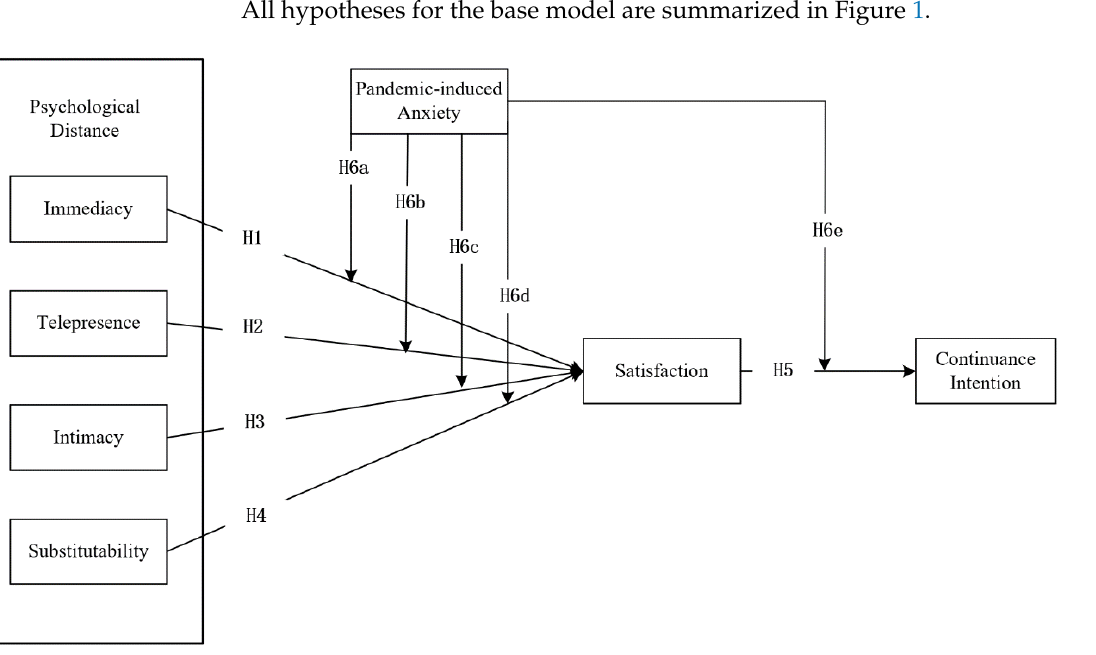
Figure 1. Conceptual model of the determinants of CI towards MMC.